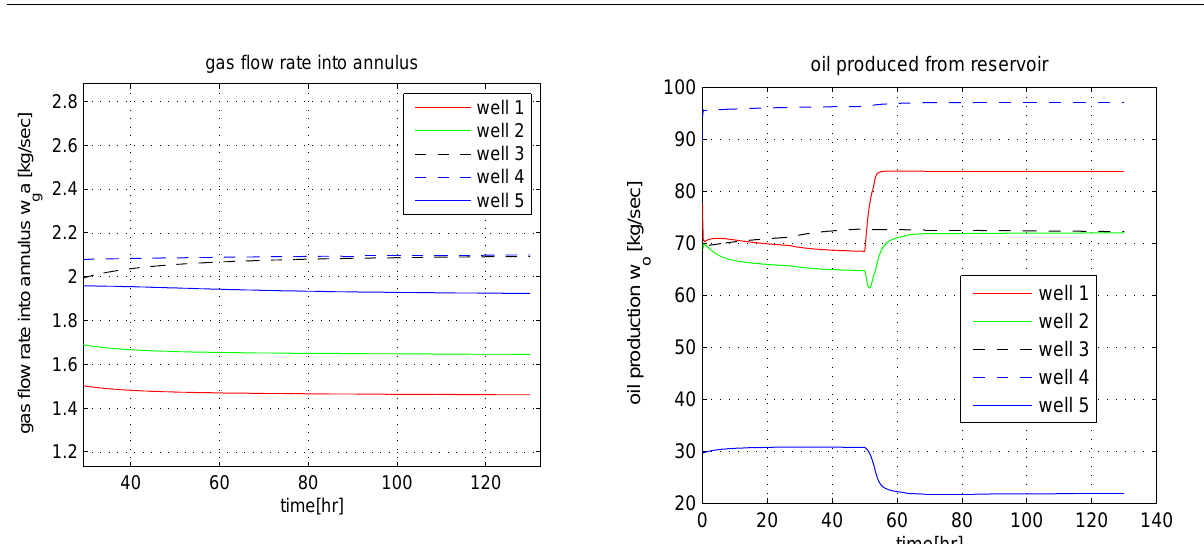
Figure 9: Oil produced from each oil well after